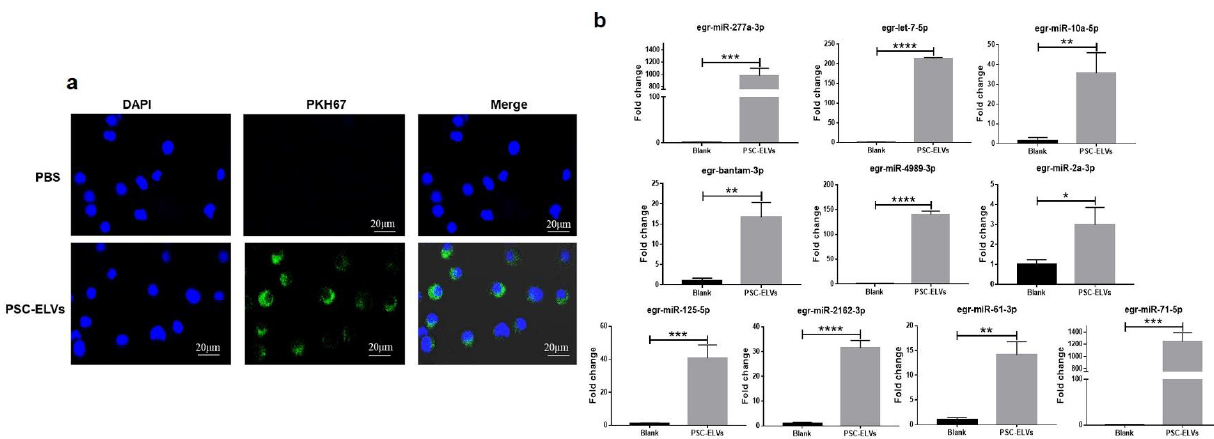
Figure 2. PSC-ELVs were internalized by mouse bone marrow-derived dendritic cells (BMDCs), and parasite miRNAs were transferred into the BMDCs. ( a ) BMDCs and PSC-ELVs were stained with a nuclear marker (DAPI, blue) and PKH67 (green) and were viewed under a confocal microscope (magnification 40×) Scale bars: 20 μm ; ( b ) Quantitative real-time reverse transcription-PCR ( qRT- PCR) analysis of parasite miRNAs in BMDCs after PSC-ELVs co-culture. * p < 0.05; ** p < 0.01; *** p < 0.001; **** p <